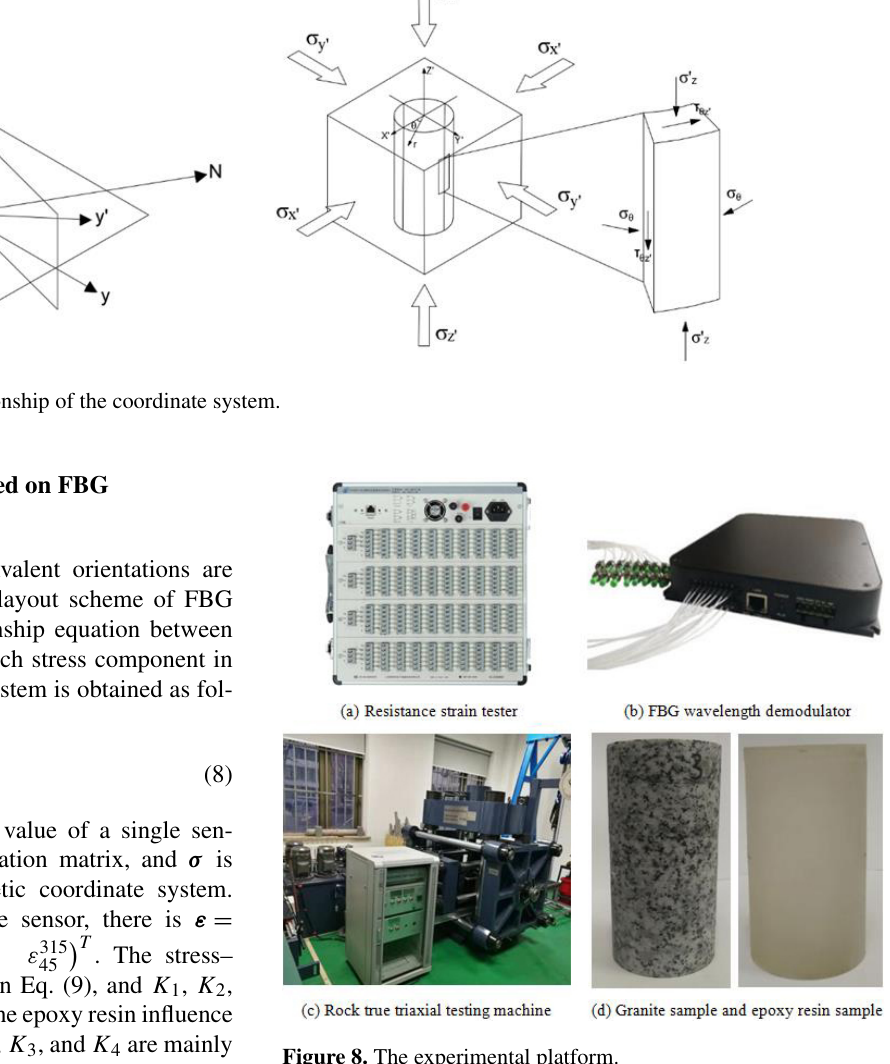
Figure 8. The experimental